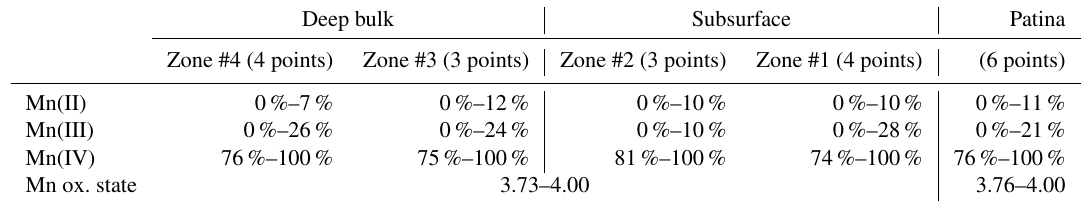
Figure 7. Representative (a) XRD patterns and (b) Raman spectra obtained for Mn-rich phases from L1 bulk and patina. δ -MnO 2 was synthesized as described by Grangeon et al. (2008). (c) Comparison of a representative Raman spectrum obtained from L1 bulk with that of natural hollandite. Table 2. Relative proportions of Mn(II), Mn(III), and Mn(IV) determined using the Combo method in L1 regions of